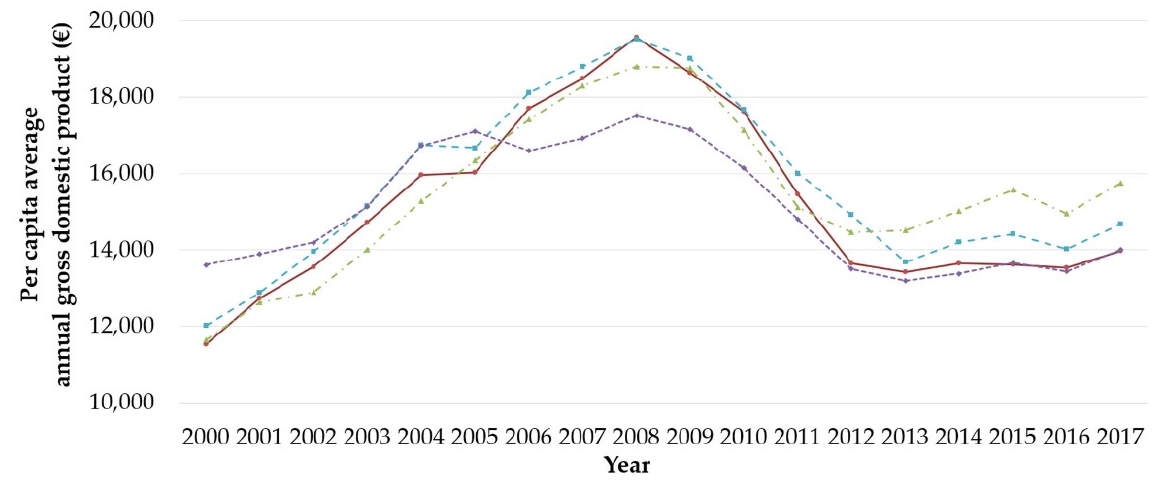
Figure 3. Variation of per capita average annual gross domestic product versus time (2000–2017) in Crete, adapted from [48].